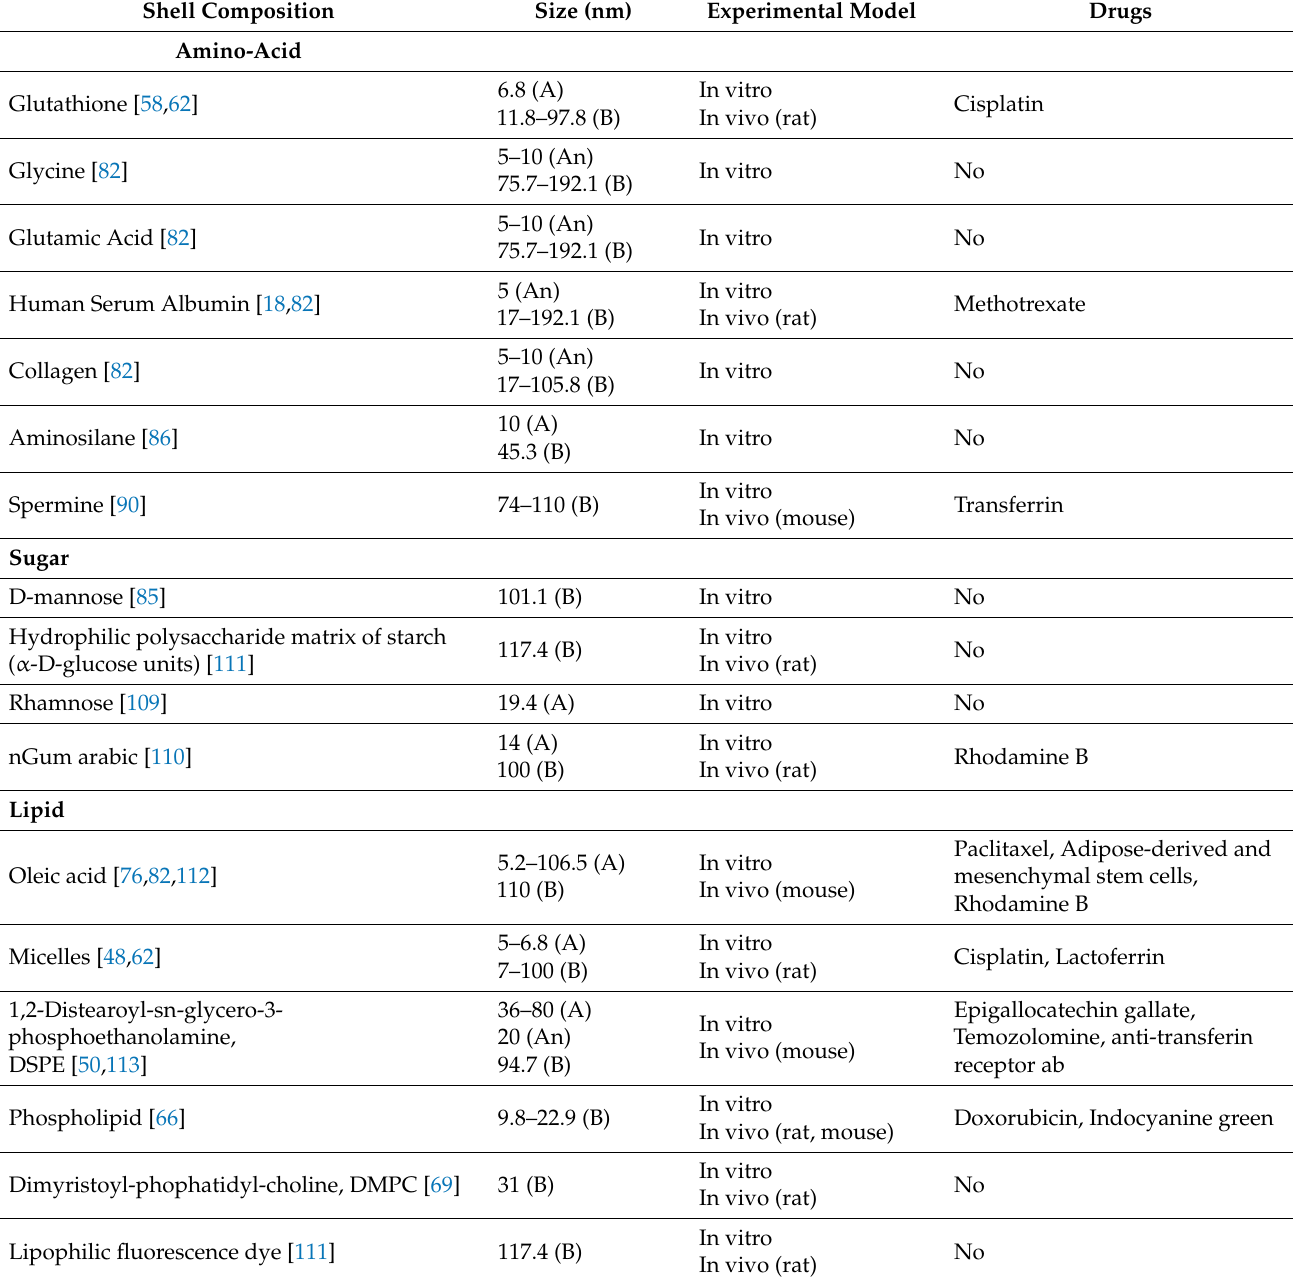
Table 2. Polymer SPIONs shells derived from amino acids, sugar, and lipids. A: core size with shell (Transmission Electron Microscopy), B: hydrodynamic size with shell (Dynamic Light Scattering), An: naked core size, Bn: naked hydrodynamic